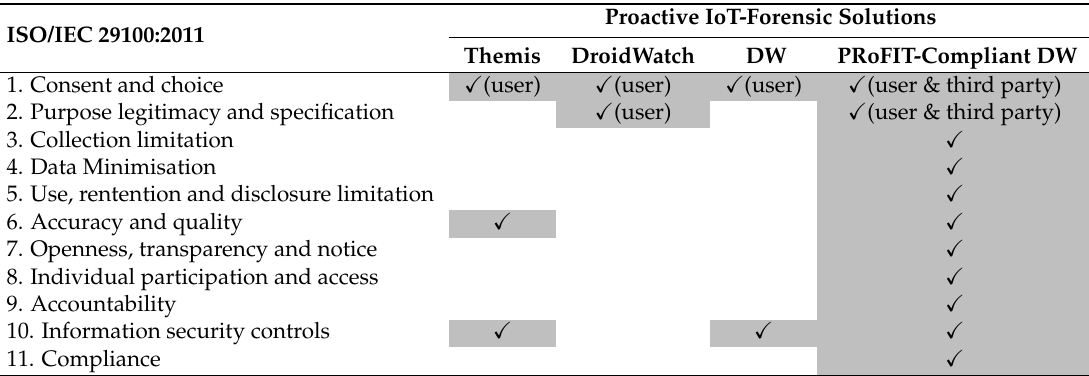
Table 4. Related work that considers